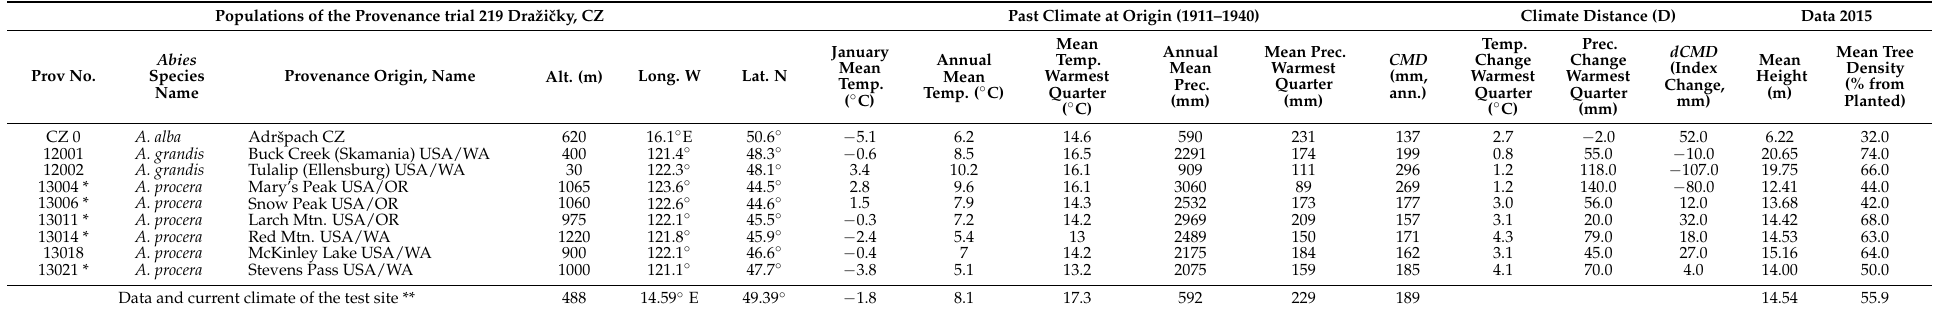
Table 5. Basic data of the provenance trial 219 Dražiˇcky: location and climate of species and populations used for analysis (sequence and geographic data of provenances are identical to the source publication (Adapted partly from [20]). Climate distances refer to the trial